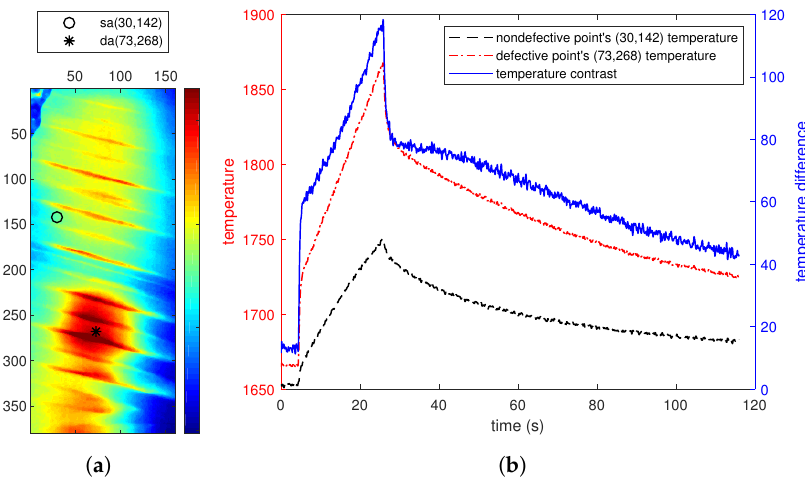
Figure 13. ATC; Experiment 3. ( a ) Selected points. ( b ) Temperature-time graph and thermal contrast.